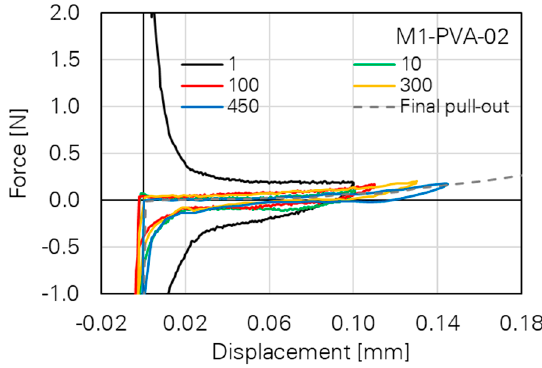
Figure 7. Cyclic, double-sided single fibre pull-out test with PVA fibre [33].